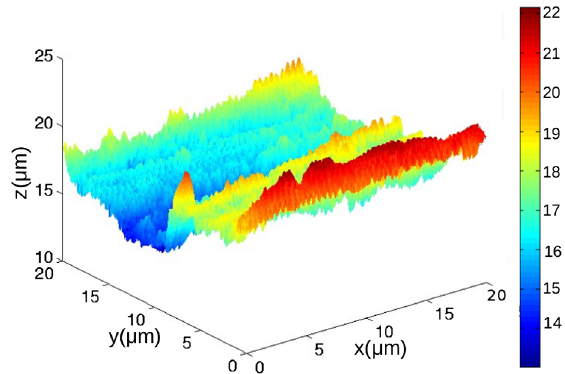
FIG. 9. Raw surface image scan of a 20 μ m by 20 μ m area of aluminum sample